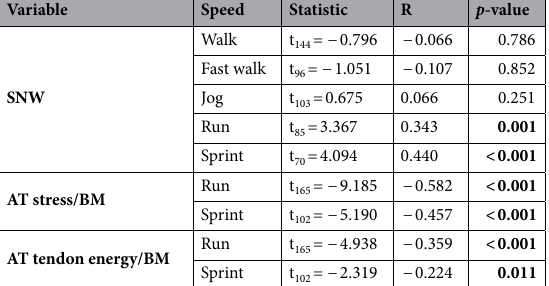
Table 2. Pearson’s correlation coefficient comparisons between ankle SNW, mass-specific stress, and mass- specific elastic energy storage and the Achilles tendon moment arm at different speeds. Bolded values indicate significance at p ≤